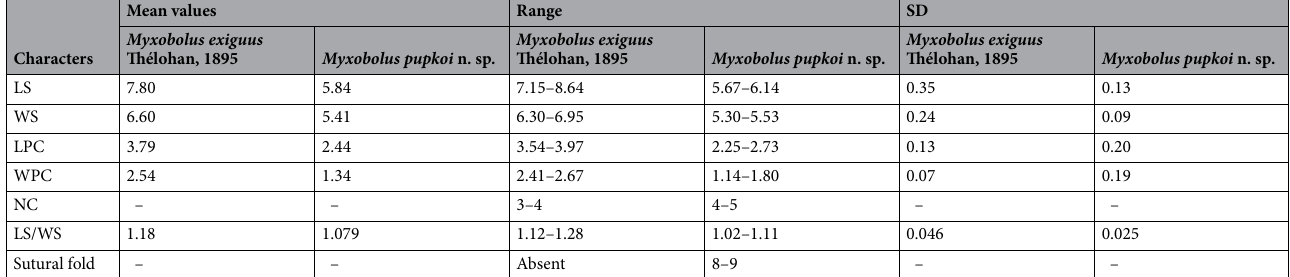
Table 1. Measurements (µm) and ratio of Myxobolus exiguus Thélohan, 1895 and Myxobolus pupkoi n. sp. (n = 12). LS length of spore, WS width of spore, LPC length of polar capsule, WPC width of polar capsule, NC number of coils, SD standard